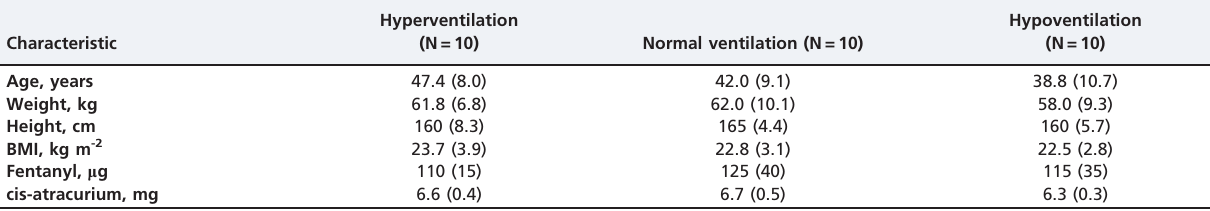
Table 1 - Patient demographic characteristics for the three ventilation